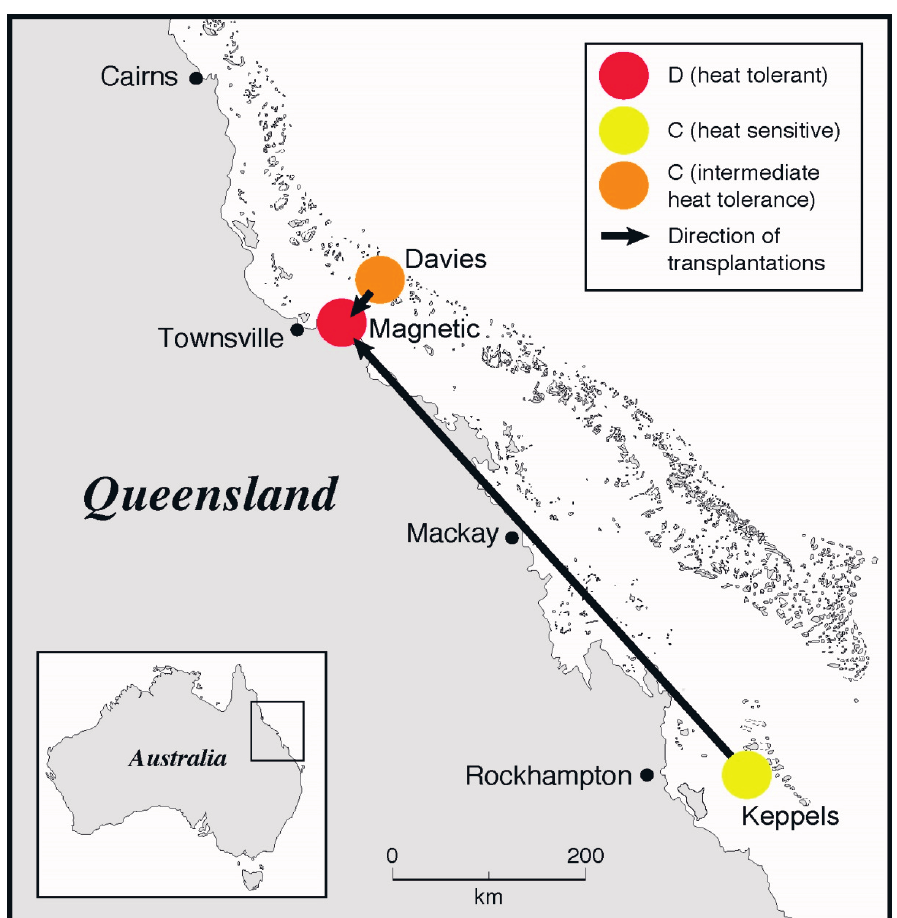
Figure 1. Location map of coral transplants from the cooler waters of the southern inshore GBR (Keppels) and central offshore waters of the GBR (Davies Reef), to the warmer inshore waters of the central GBR (Magnetic Island) (adapted from [22], with permission from © 2006 The Royal